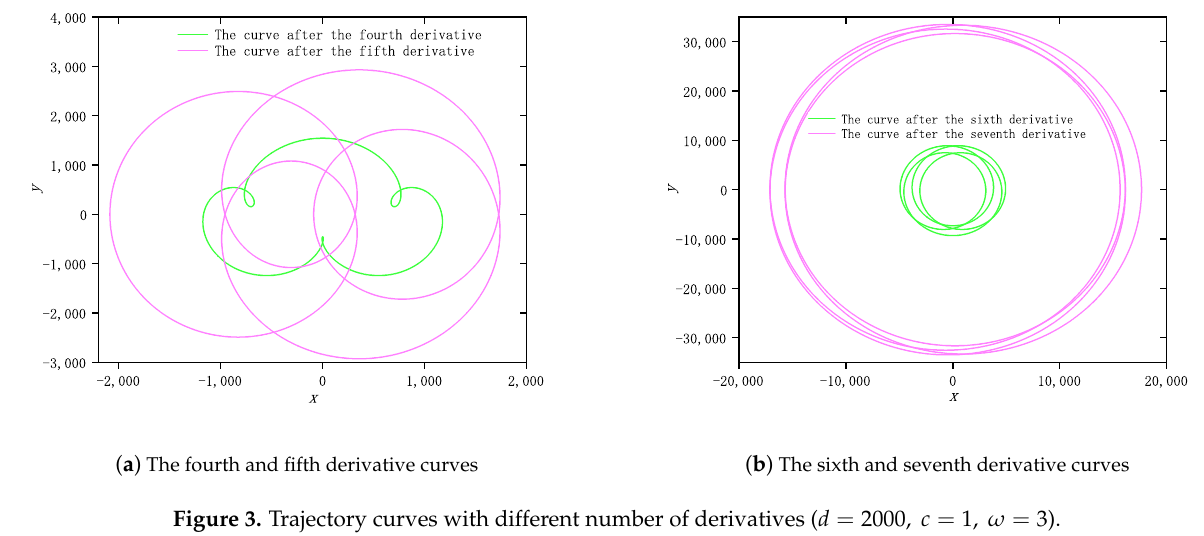
Figure 3. Trajectory curves with different number of derivatives ( d = 2000, c = 1, ω =